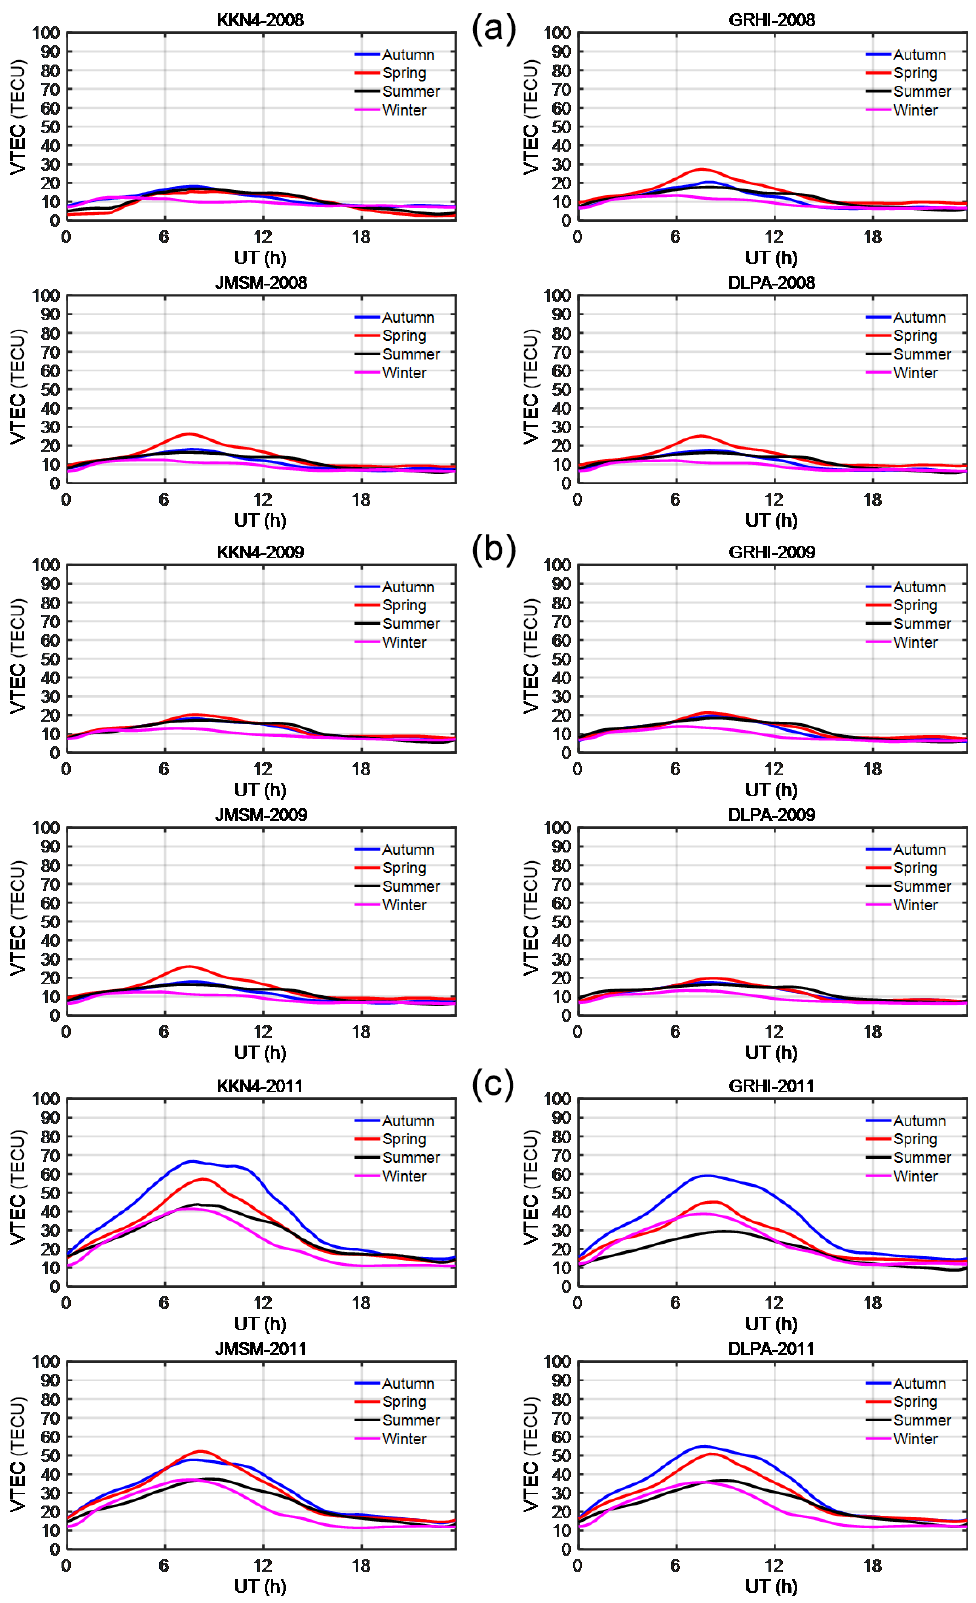
Figure 6. https://doi.org/10.5194/angeo-39-743-2021 Ann. Geophys., 39, 743–758,